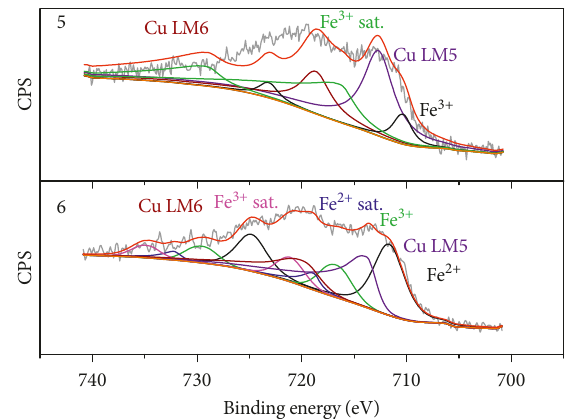
Figure 11: Fe2p spectra of CuO adsorption with and without different